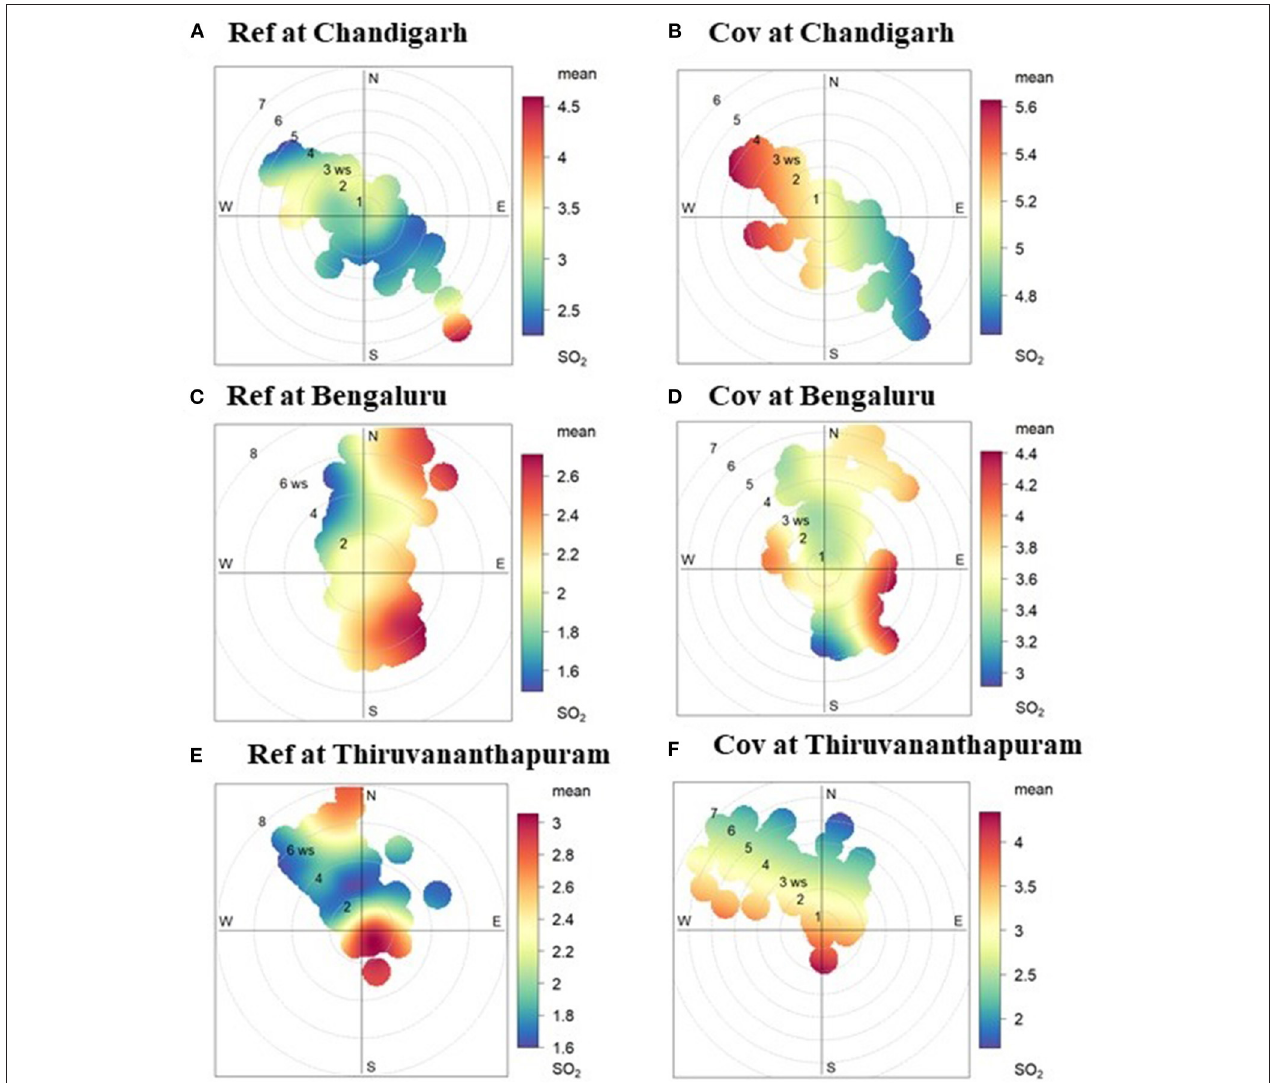
FIGURE 3 | Bivariate polar plots of SO 2 for (A,B) Chandigarh, (C,D) Bengaluru, and (E,F) Thiruvanthapuram during reference and lockdown period due to COVID, respectively. The color bars show SO 2 AQI values for respective plots.